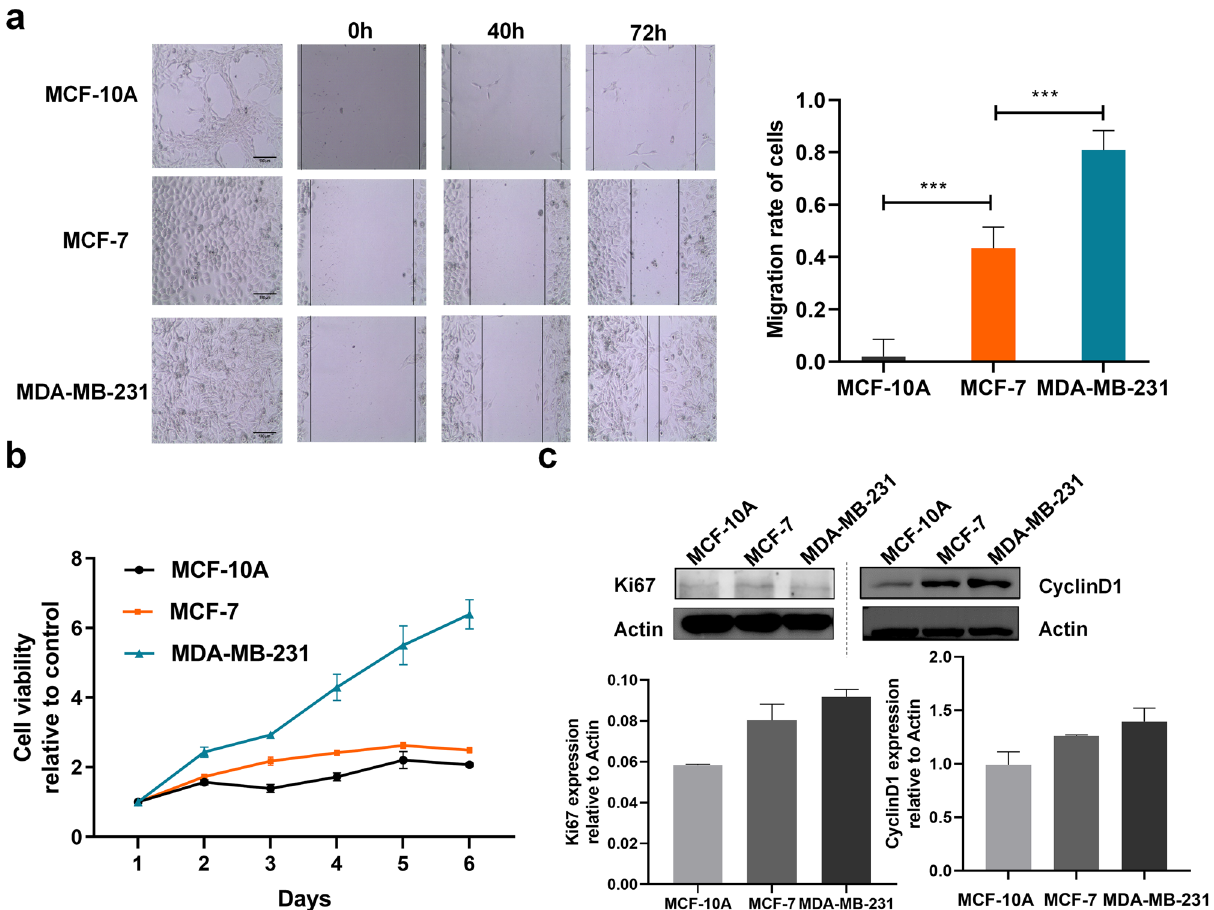
Figure 3. Migration and expression of Ki67 and cyclinD1 in three types of breast cells. ( a ) Micrographs of the migration of three types of breast cells (MCF-10A, MCF-7 and MDA-MB-231) during 72 h culture. Comparison of the migration rate in terms of area coverage calculated using Image J, as shown in the right. (Data are means ± SD, n = 6). ( b ) The growth curves of the three types of breast cells during 6 days of culture. (Data are means ± SD, n = 3). ( c ) Western blot of Ki67 and cyclinD1. The expression levels of Ki67, cyclinD1 in comparison with actin control for three cell types were quantified using Image J and presented below. (Data are means ± SEM, n = 3). *p < 0.05; **p < 0.01; **p <